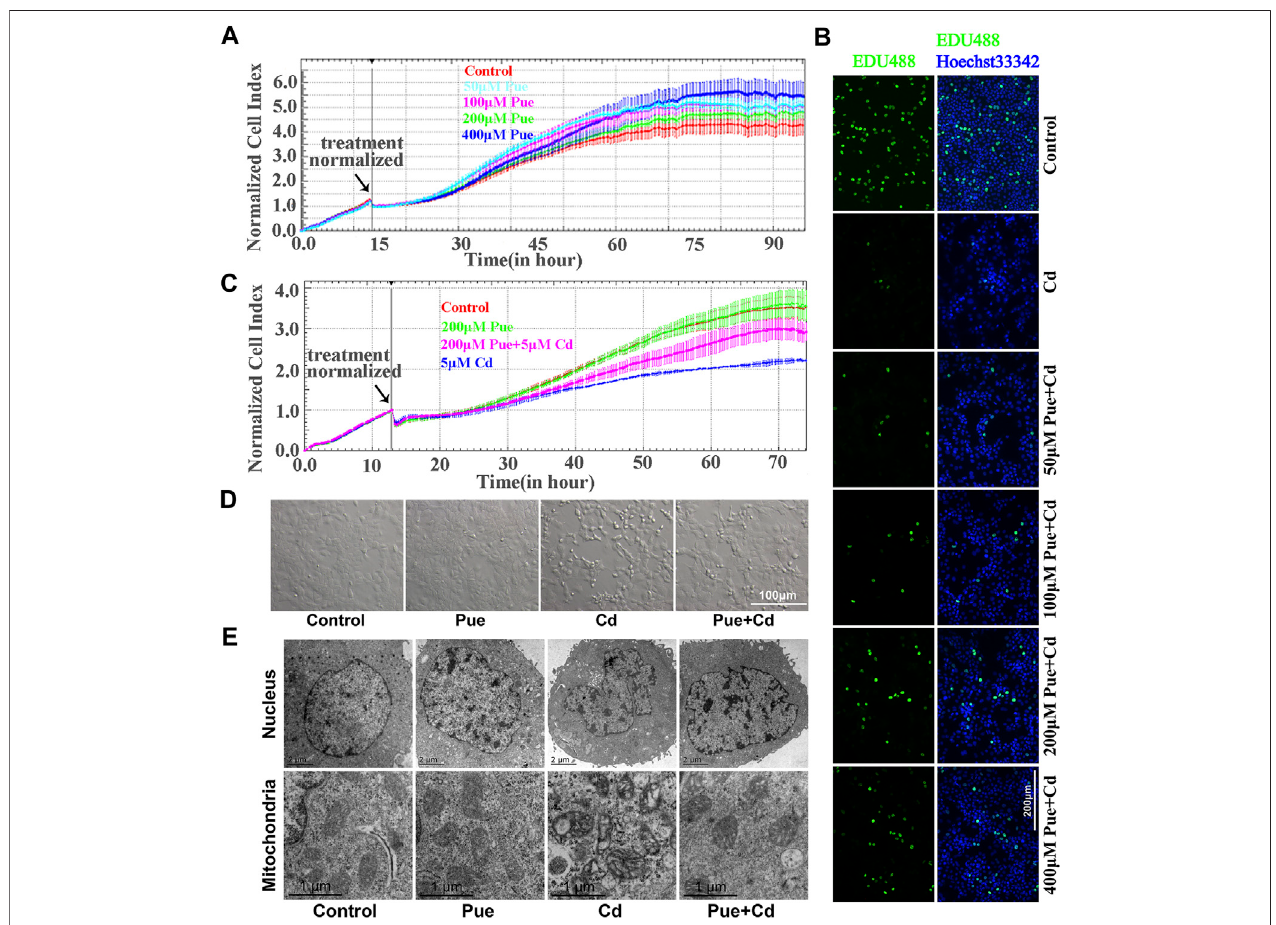
FIGURE1| PuealleviatedCd-inducedinjuryinAML12cells. (A) EffectofPueatdifferentconcentrations(50,100,200,and400 μ M)ontheCIinAML12cells.Error bars represents the standard deviation (n (cid:2) 3). (B) After treatment with Pue (50, 100, 200, and 400 μ M) and/or 5 μ M Cd for 24 h, cell proliferation was detected by EdU staining. Scale bar (cid:2) 200 μ m. (C) Effect of Pue and Cd, alone or in combination, on CI in AML12 cells. Error bars represents the standard deviation (n (cid:2) 3). (D) Effect of PueandCd,aloneorincombination,oncellmorphology.Scalebar (cid:2) 100 μ m. (E) AftertreatmentwithPueandCd,aloneorincombination,for12 h,thechangesin cell ultrastructure was analyzed under a transmission electron microscope and representative images are shown. Scale bar in nuclei (cid:2) 2 μ m; scale bar in mitochondria (cid:2) 1 μ m.